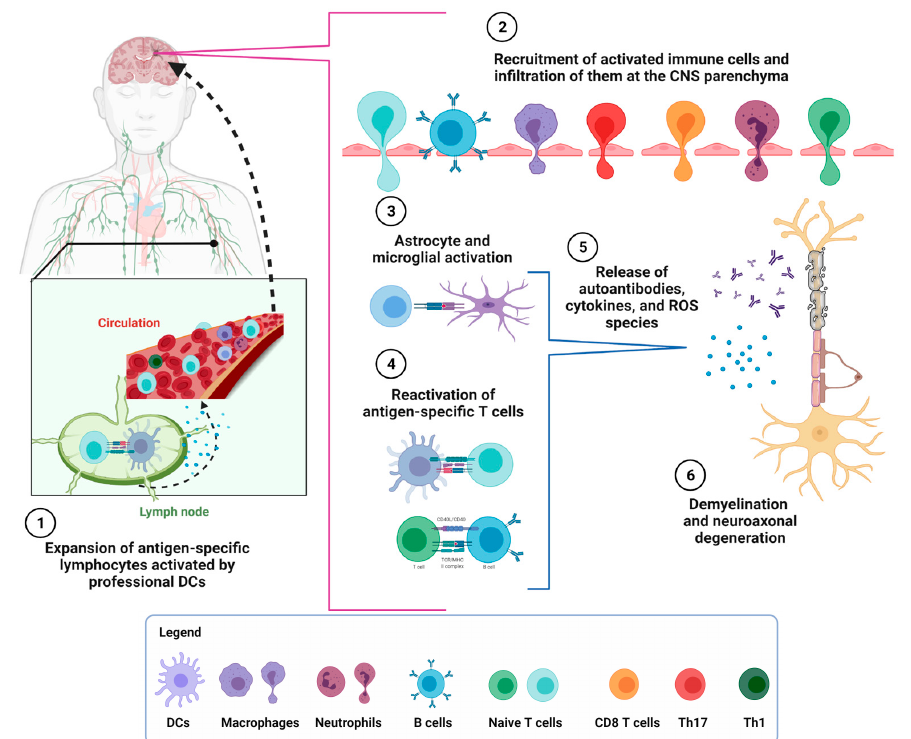
Figure 1. The immune interplay in MS pathogenesis. MS has a heterogeneous presentation and a robust immune component that underlies its development. (1) Autoantigens against the myelin basic protein (MBP) and the myelin oligodendrocyte glycoprotein (MOG) are released into circulation and captured by professional dendritic cells (DCs), which present them to naive T cells in secondary lymphatic organs. In parallel, B cells are activated mainly in CSF. (2) Anti-MBP and anti-MOG antibodies and chemokines allow the recruitment of activated T effector and innate cells infiltrating the CNS parenchyma due to altered permeability of the blood–brain barrier (BBB). (3–4) Effector T and B cells are re-activated inside the CNS by astrocyte and microglial cells, (5) increasing local pro-inflammatory cytokines and reactive oxygen species (ROS) production, (6) which destroys the myelin sheath, thereby causing demyelination, oligodendrocyte loss, gliosis, and neuroaxonal degeneration. This damage is observed in patients as demyelinated areas called plaques, which are the distinctive feature of MS. Created with BioRender.com (accessed on 1 June